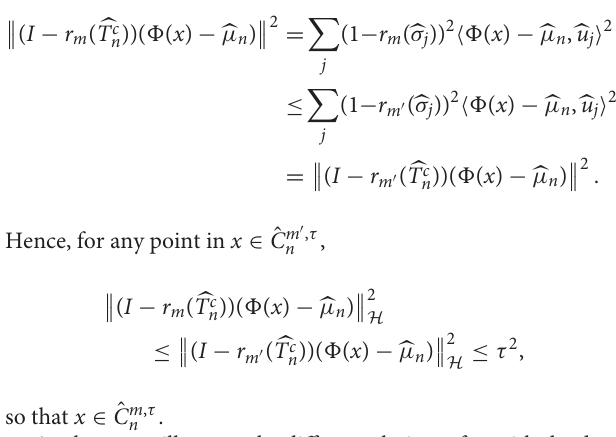
of Example 2. The training set is sampled from the distribution supported on the curve Lis 2,0.11,1,0.3 (see panel right of Figure 2